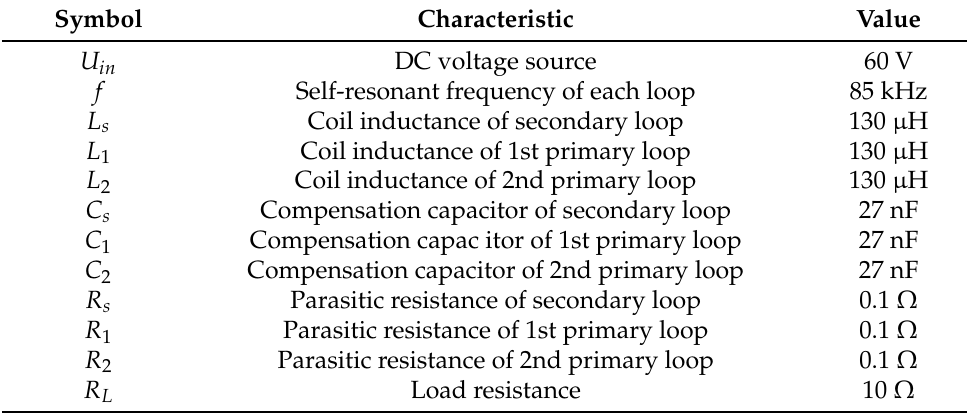
Table 1. Two-to-one WPT topology simulation